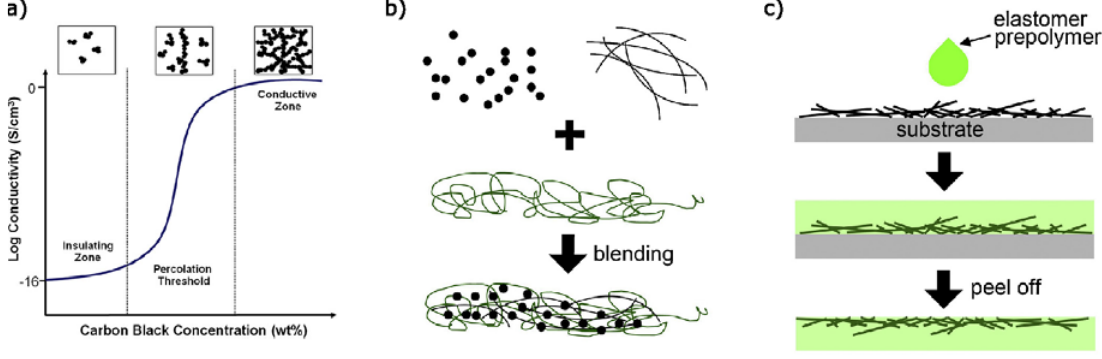
Figure 2: ( a ) typical behavior of conductivity at percolation threshold ( b ) bulk mixing of conductive fillers in elastomer ( c ) surface embedded wires through peel method. Adapted with permission from [42,43].